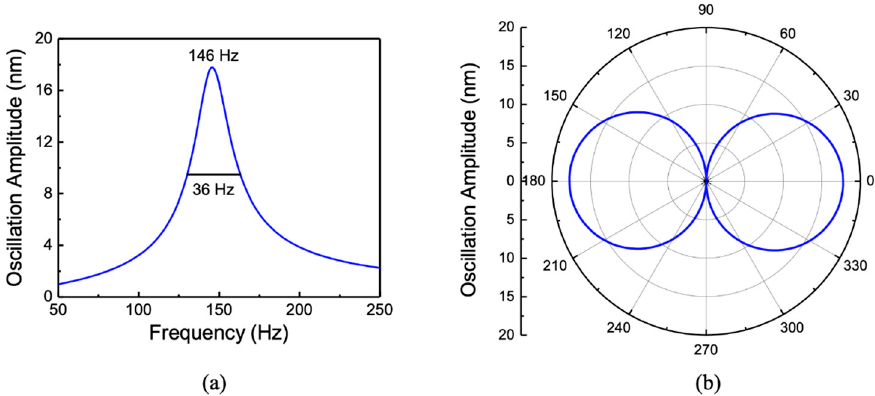
Figure 2. Simulated ( a ) frequency and ( b ) directional responses of the MEMS sensor when immersed in silicone oil.